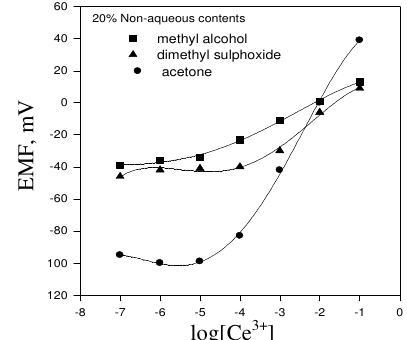
Figure 3. Effect of pH on the response of Ce(III)-selective electrode based on DB24C8. Table 2. Selectivity coefficient values for Ce(III)-selective electrode based on DB24C8 as calculated by FIM method.